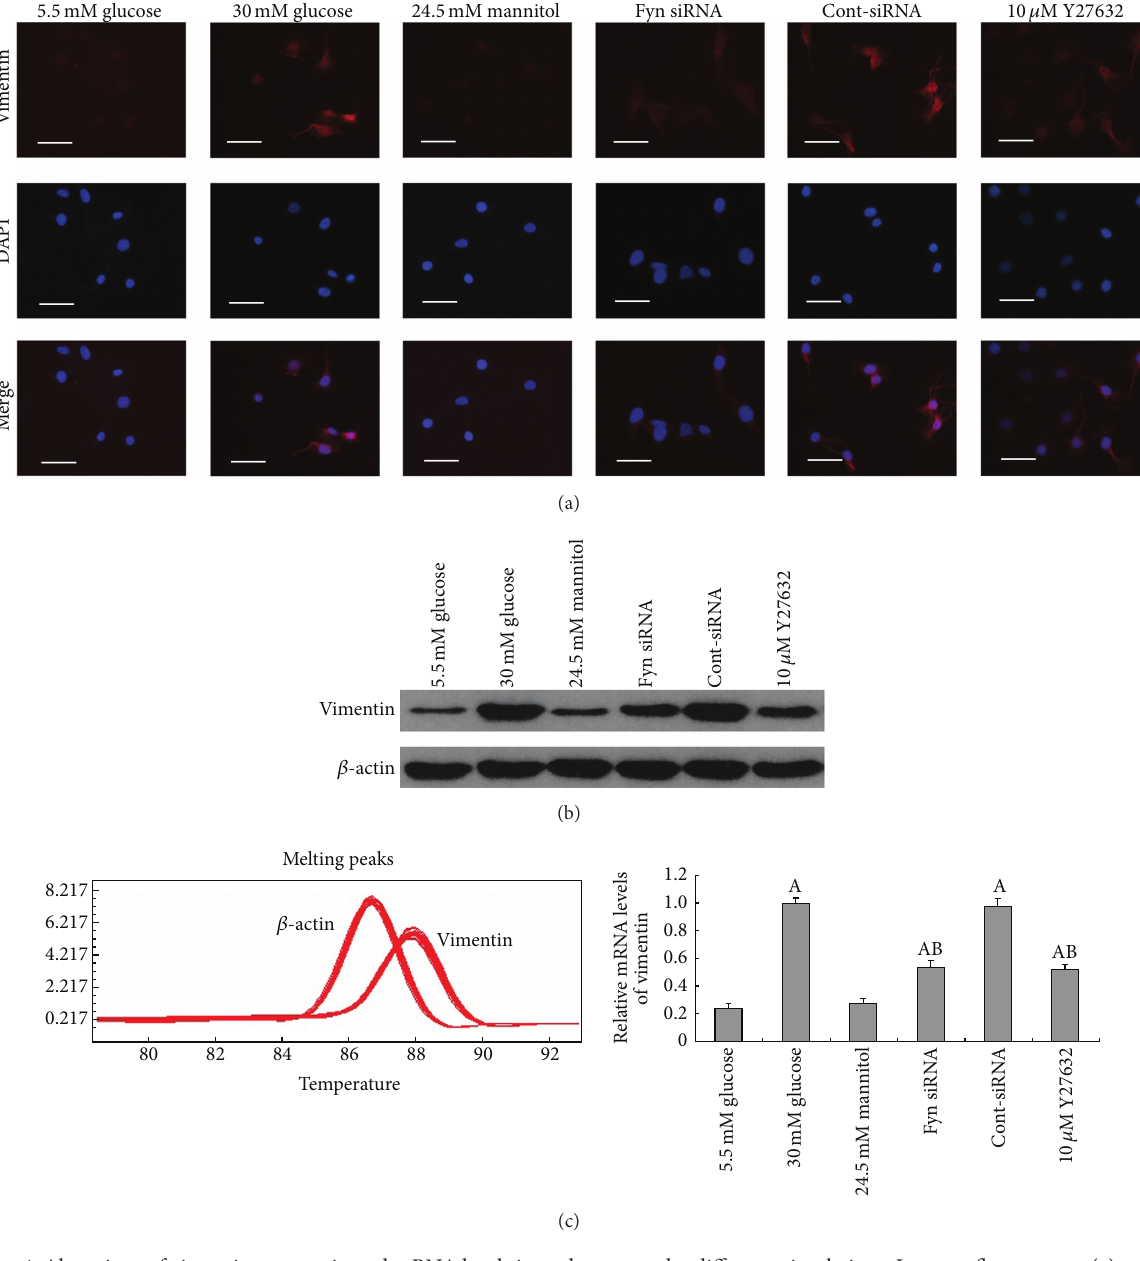
Figure 4: Alterations of vimentin on protein and mRNA levels in podocytes under different stimulations. Immunofluorescence (a), western blot (b), and real-time PCR (c) presented that vimentin expression was increased markedly following incubation with 30 mM glucose for 48 hours (column 2), and the increase was partially inhibited by transfection with Fyn siRNA for 24 hours (column 4) or pretreatment with 10 𝜇 M Y27632 for 30 minutes (column 6). Control podocytes were treated with Cont-siRNA (column 5) or 5.5 mM glucose plus 24.5 mM mannitol (column 3). Magnification: 400x. Values denote the mean ± SD; A 𝑃 < 0.05 versus 5.5 mM glucose and B 𝑃 < 0.05 versus 30mM